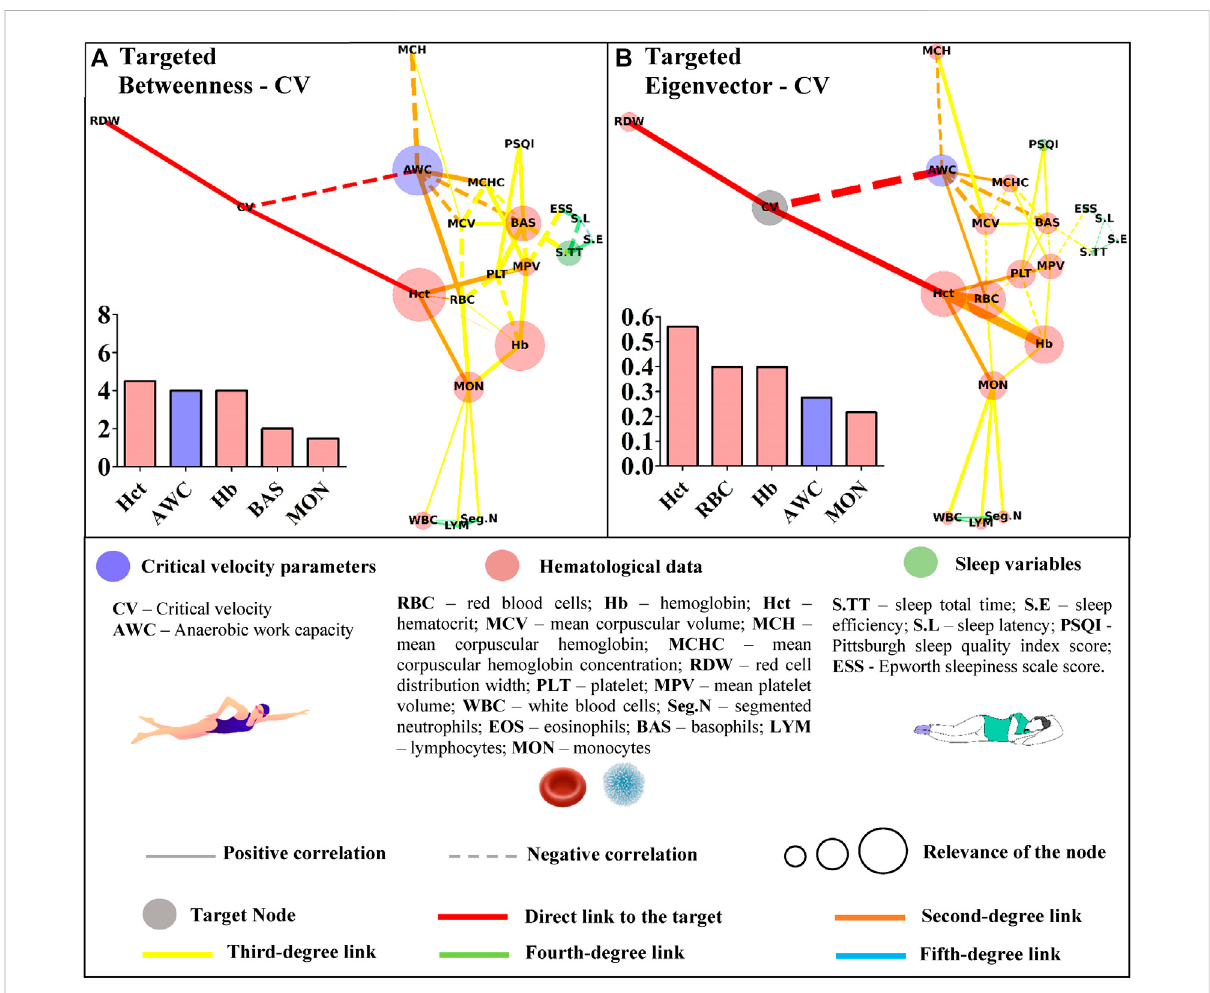
FIGURE 4 Centrality measurements from the targeted complex network model; (A) betweenness analysis considering the critical velocity (CV) as the target node. The thickness of the edge is directly related to the “ distance ” between the nodes connected by the edge (lower thickness means